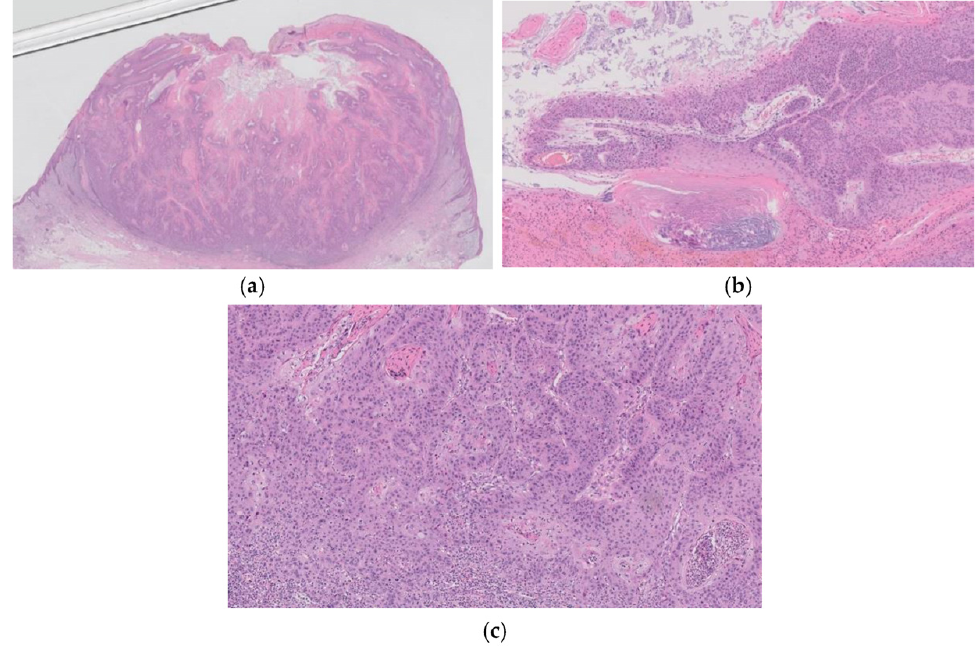
Figure 11. Histopathological findings of cSCC. A multilobular crateriform lesion ( a ) with epithelial lip- like structures ( b ) is observed. The full epidermal thickness of atypical keratinocytes with bowenoid features is evident at the base of the crater ( c ). There are no large, pale pink keratinizing cells with a glassy appearance featuring isthmic differentiation in the lobules ( c ). The histopathological features of solar keratosis are also observed in the periphery of the lesion ( b